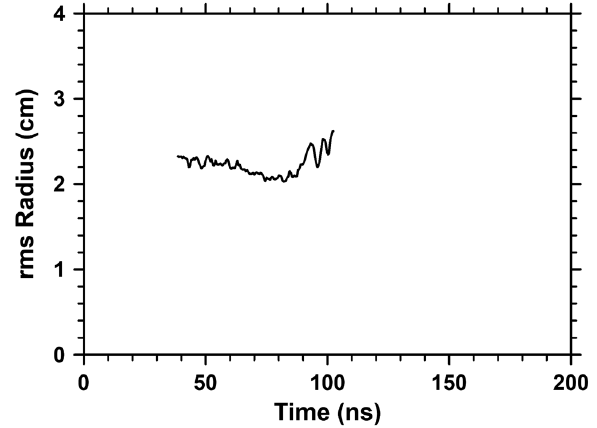
FIG. 8. Beam rms radius measured by the DML for shot